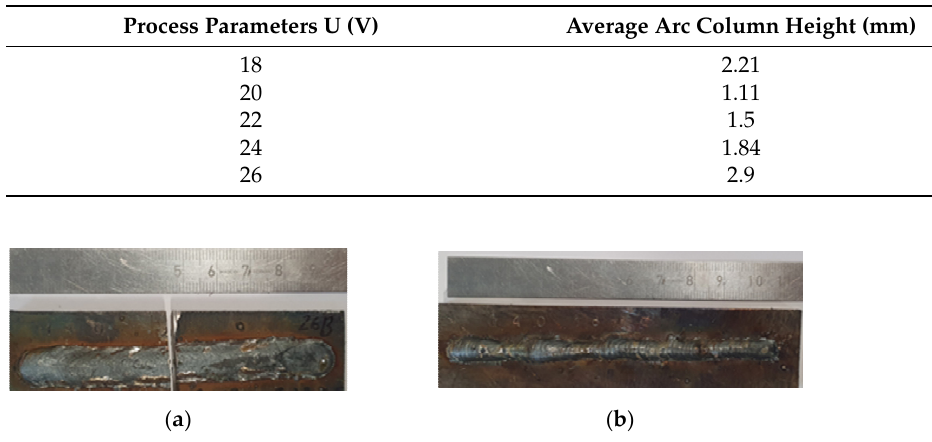
Figure 9. The appearance of the bead, ( a )—I = 120 A, U = 26 V; ( b )—I = 120 A, U = 18 V. Good results of arc characteristics were obtained using U = 20 V and I = 101–120 A.